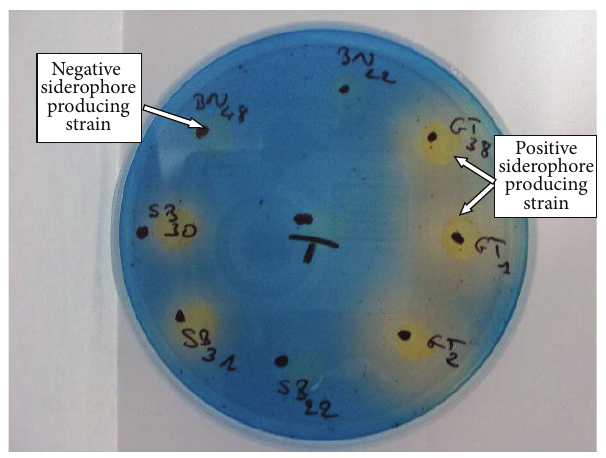
Figure 6: Screening of siderophore producing actinobacteria using chrome azurol S agar (positive strain are yellow-orange, negative strain are blue).